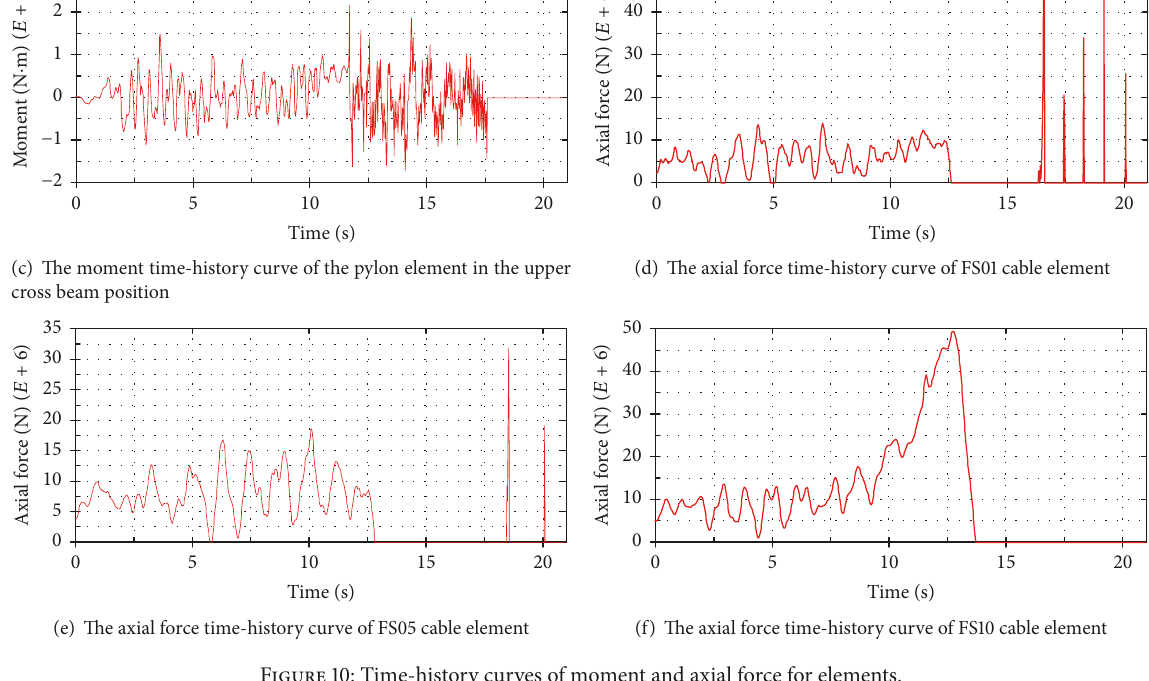
Figure 10: Time-history curves of moment and axial force for elements.